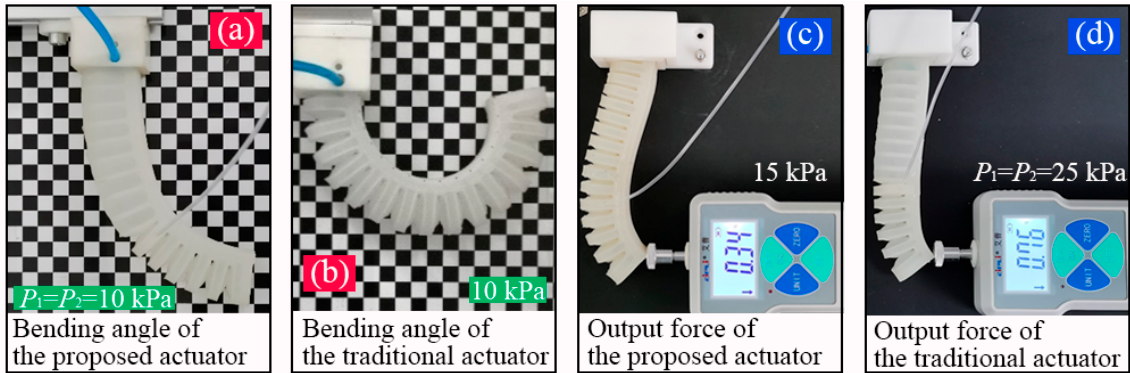
Figure 12. Measurement of the bending deformation and output force of two kinds of soft actuators: ( a , b ) bending deformation of the proposed soft actuator and the traditional one and ( c , d ) measuring of the output force of the proposed soft actuator and the traditional one.